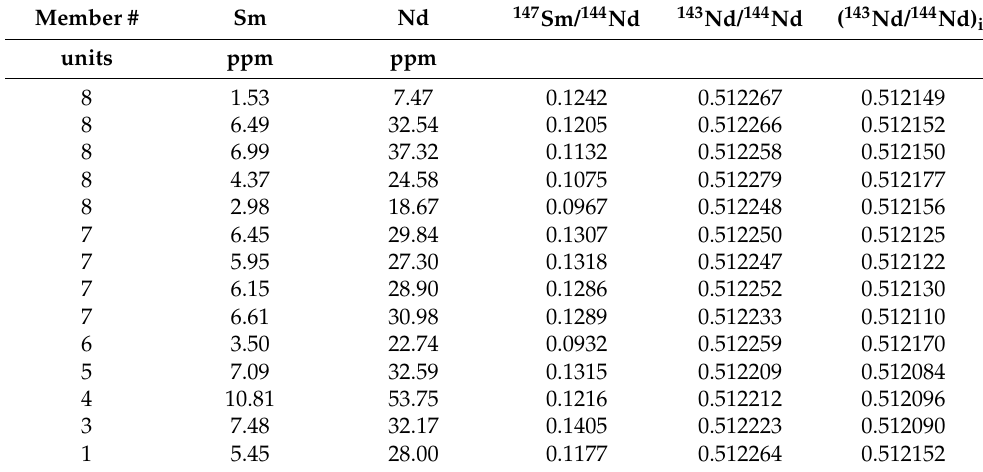
Table 2. Sm and Nd content and isotope composition (TIMS), ( 143 Nd/ 144 Nd) i is the ratio corrected for the time of the Bazhenov Formation